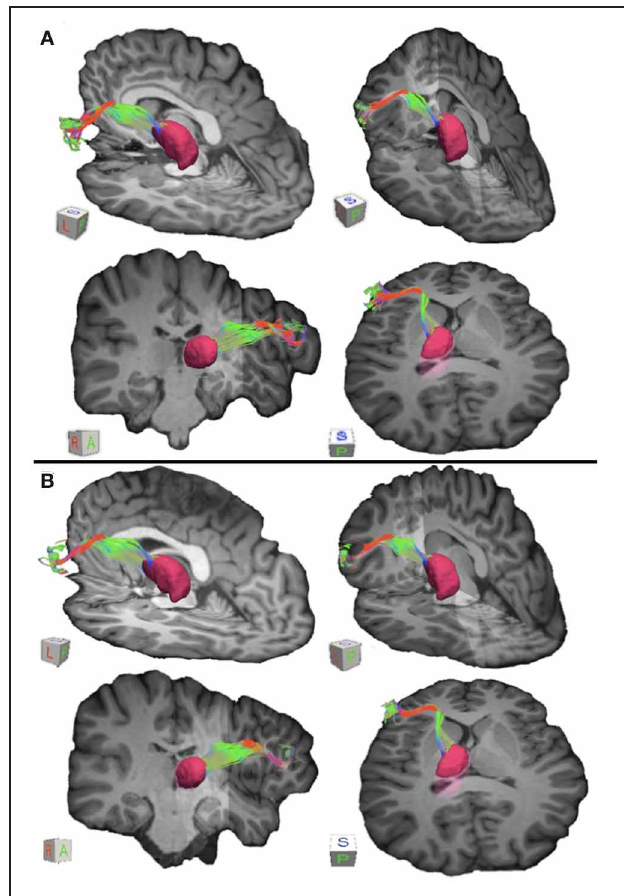
FIGURE 3 | Connections between pars triangularis (A) and pars opercularis (B) and the thalamus (pink) in a representative participant (participant 3). Color gradient of the pathways and letters on the faces of the cubes have the same designation as in Figure 1 .